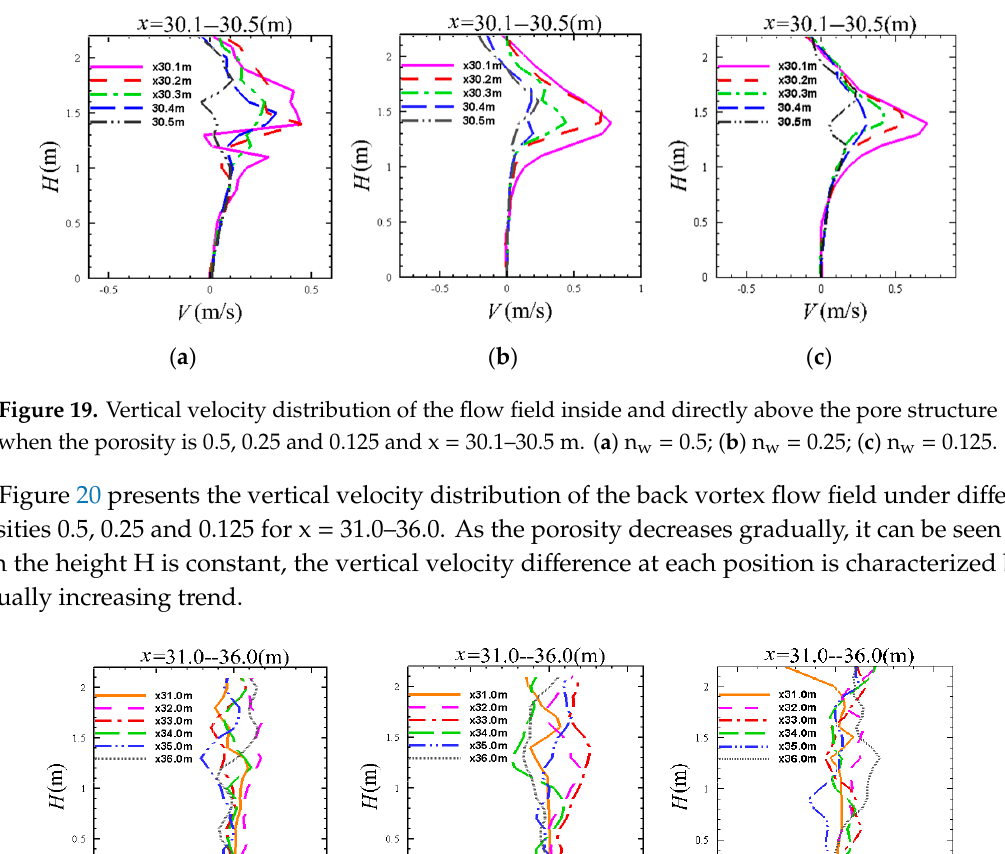
Figure 18. Vertical velocity distribution of the flow field in the upstream area of the pore structure when the porosity is 0.5, 0.25 and 0.125 and x = 25.0–29.0 m. ( a ) n w = 0.5; ( b ) n w = 0.25; ( c ) n w = 0.125.